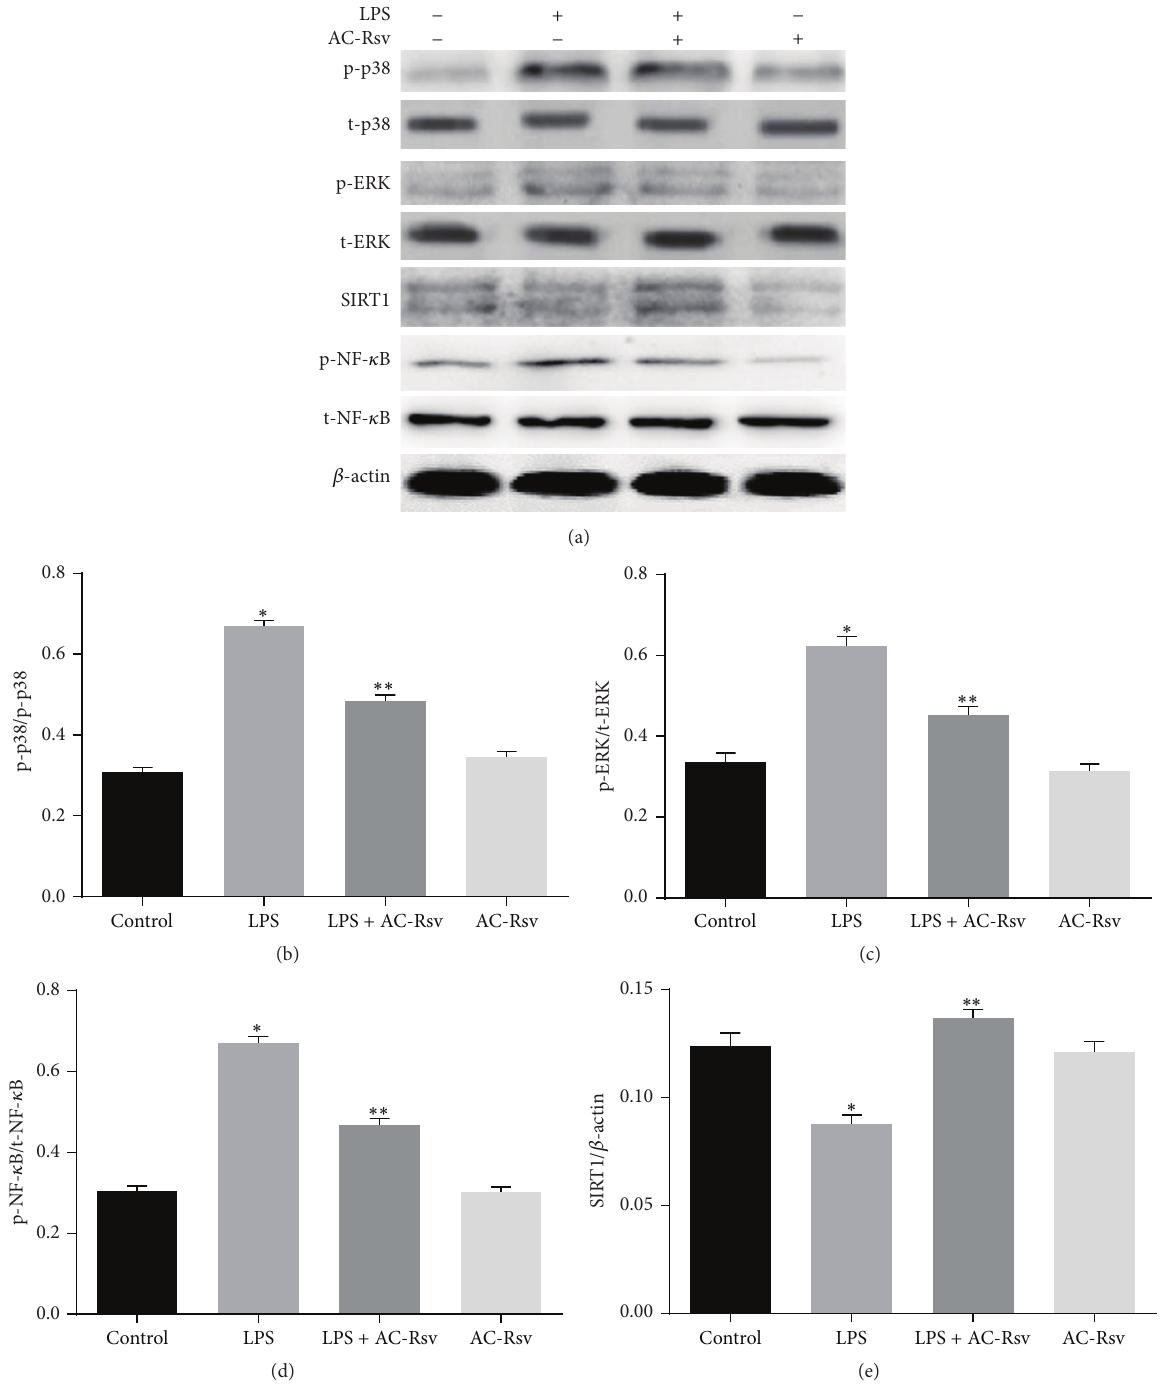
Figure 6: Effects of AC-Rsv on the expression of MAPK/SIRT1 axis in lungs were evaluated by western blot. Relative expression levels of p-p38 MAPK, p-ERK, and p-NF- 𝜅 B were normalized to the expression levels of their total forms; SIRT1 expression was expressed by comparing with that of 𝛽 -actin. Administration of LPS significantly decreased the SIRT1 expression and increased the expression of p-p38 MAPK, p-ERK, and p-NF- 𝜅 B in lungs compared with that of control, ∗ 𝑃 < 0.05 versus control, while AC-Rsv treatment dramatically decreased expression of p-p38 MAPK, p-ERK, and p-NF- 𝜅 B and enhanced the SIRT1 expression in lungs when challenged by LPS. ∗∗ 𝑃 < 0.05 versus ∗ 𝑃